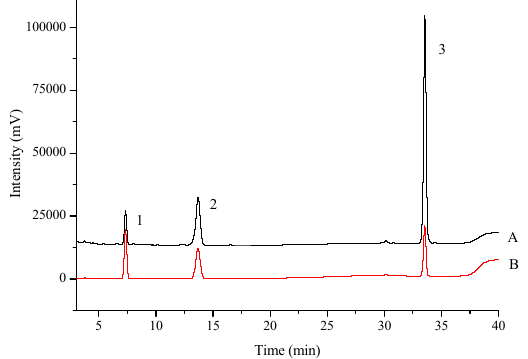
Figure 9. HPLC chromatograms of standard solution ( A ) and sample solution ( B ) 1: phenacetin; 2: 6 β -hydroxytestosterone; 3: testosterone.